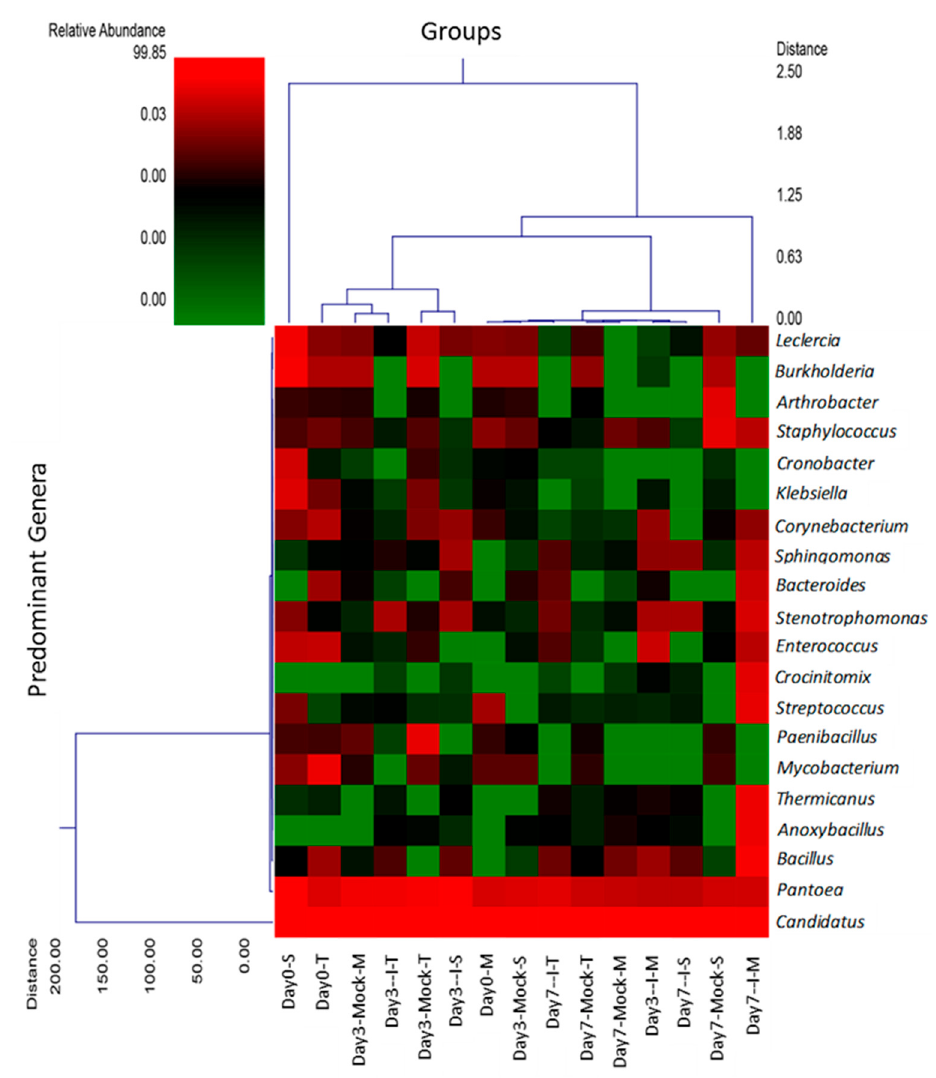
Figure 2. Dual hierarchal dendrogram evaluation of the taxonomic classification data, with each sample clustered on the X-axis labeled based on the treatment. Samples with more similar microbial populations are mathematically clustered closer together. The genera (consortium) are used for clustering. Thus, the samples with a more similar consortium of genera cluster closer together, with the length of connecting lines (top of heatmap) related to the similarity and shorter lines between two samples indicating closely matched microbial consortiums. The heatmap displays the mean relative abundance (percentages) of the top 20 predominant genera for A. flavus -susceptible (S: SC212) and -resistant (T: TZAR102; M: MI82) maize genotypes. Mock = mock control and I = A . flavus -infected. The predominant genera are represented along the right Y-axis. The legend for the heatmap is provided in the upper left corner. The data are mean ± SE of 3 replicates, and each replicate consists of four seeds.